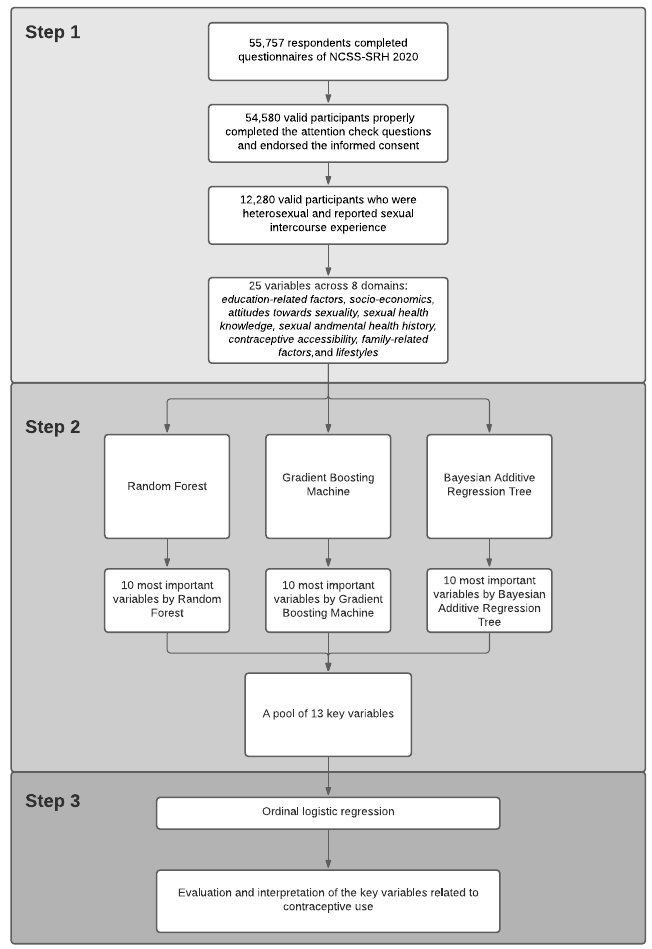
Figure 1. General workflow for identification and interpretation of the determinants associated with the frequency of contraceptive use (FCU) among young people. The general workflow contained 3 steps. Step 1 was for data preparation; Step 2 was for model training and variable selection; and Step 3 was for quantitative evaluation on key determinants by proportional odds